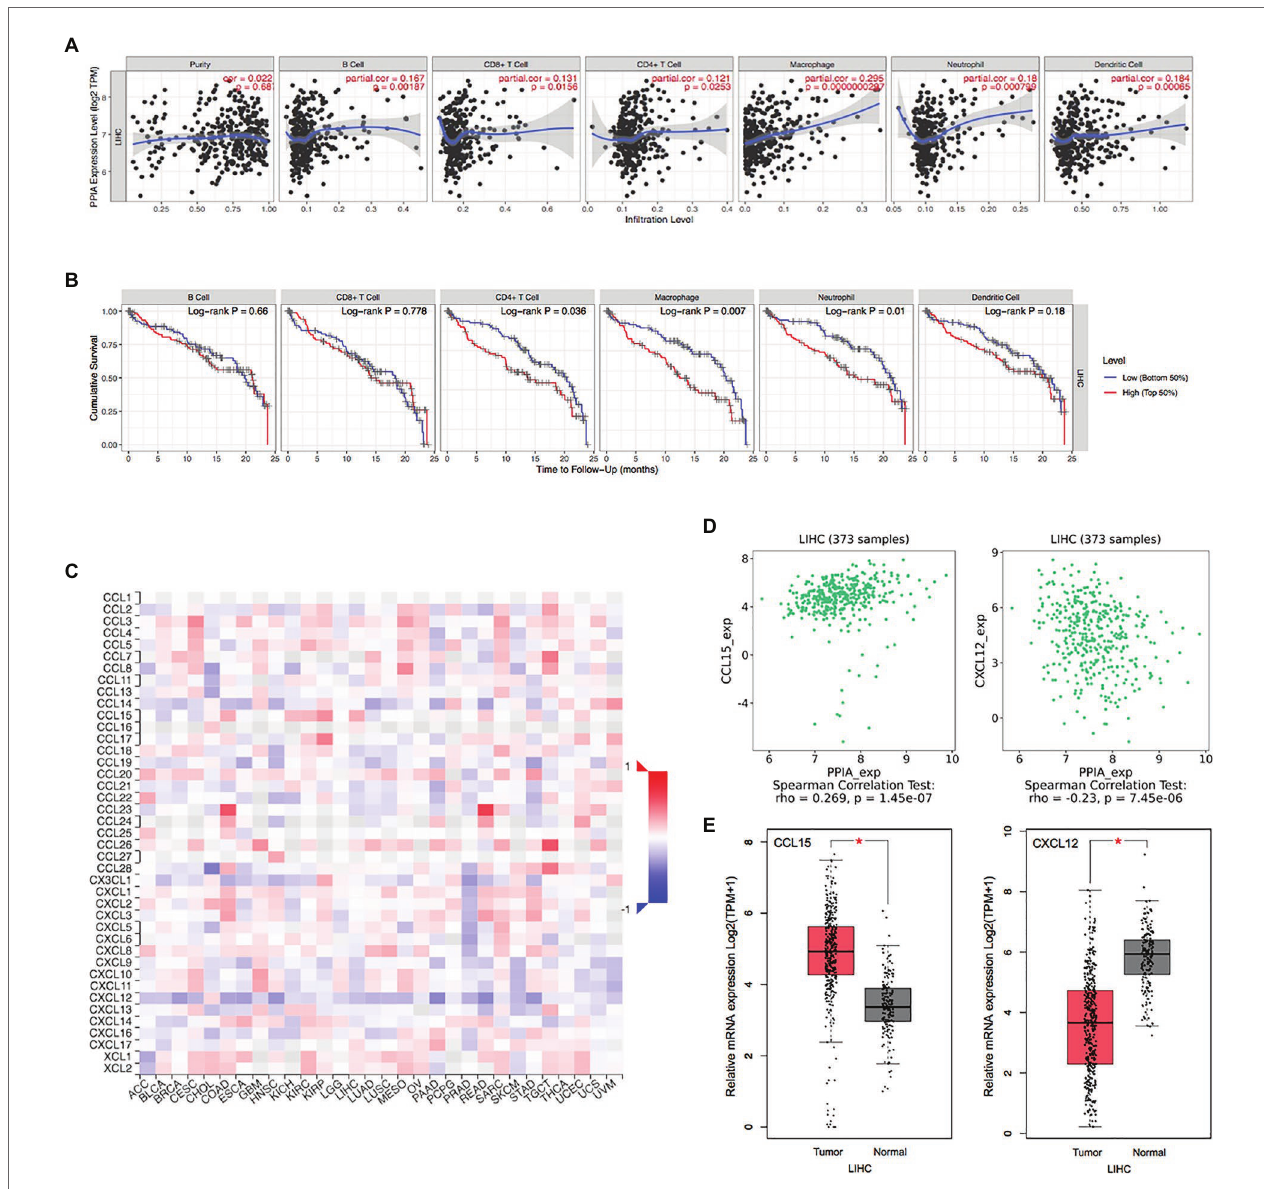
FIGURE 7 | The PPIAP22/miR-197-3p/PPIA is correlated with immune cell infiltration and chemokines in HCC. (A) Correlation of PPIA expression with immune cell infiltration in HCC analyzed using TIMER. (B) Kaplan-Meier plots for immune cell infiltration and overall survival of HCC were visualized using TIMER. (C) Correlation of PPIA expression with chemokines in HCC analyzed using TISIDB. (D) Correlation of PPIA expression with C-C motif chemokine ligand 15 (CCL15) and C-X-C motif chemokine ligand 12 (CXCL12) in HCC analyzed using TISIDB. (E) CCL15 was upregulated in tumor tissues with HCC and CXCL12 was deregulated compared with normal tissues, analyzed with GEPIA using TCGA and GTEx databases. PPIAP22, peptidylprolyl isomerase A pseudogene 22; PPIA, peptidylprolyl isomerase A; miR, microRNA; HCC, hepatocellular carcinoma; CCL15, C-C motif chemokine ligand 15; and CXCL12, C-X-C motif chemokine ligand 12. * p <